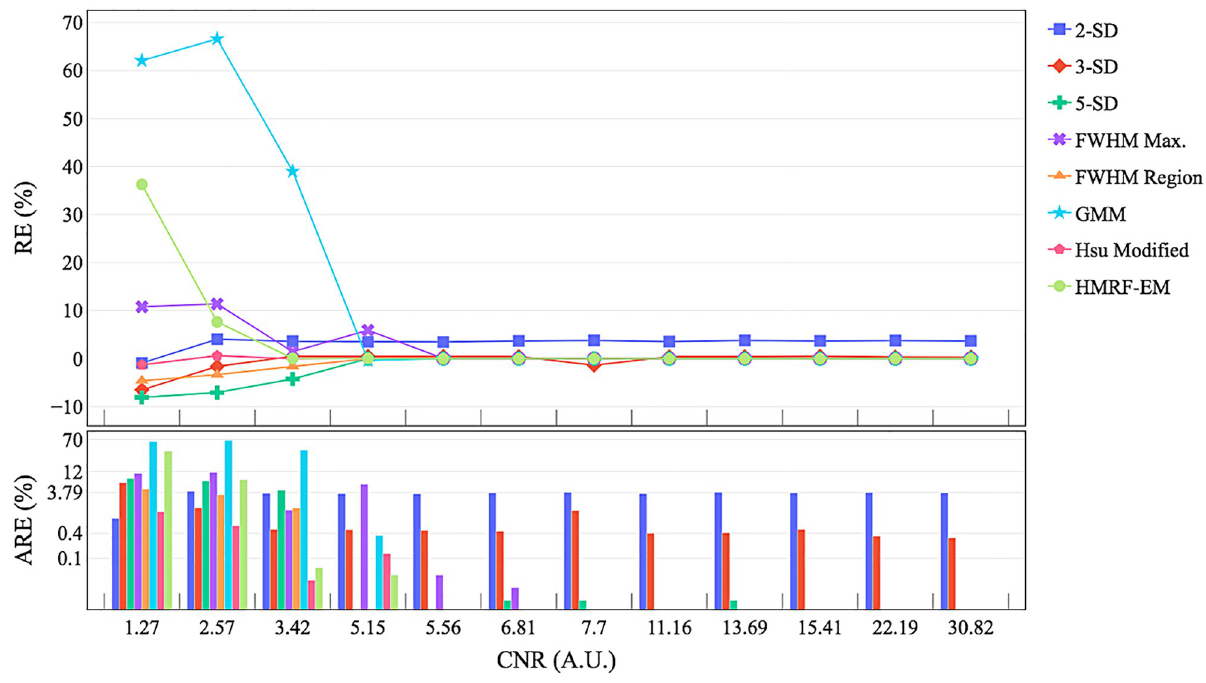
Fig 6. Performance of the lesion segmentation methods across different Contrast-to-Noise Ratio (CNR) scenarios. The curves show the relative error (RE) and bars the absolute relative error (ARE, logarithmic scale) for each segmentation method. The CNR was calculated as the ratio between the SI difference of the infarct and healthy myocardium over the standard deviation of the SI in the myocardium.